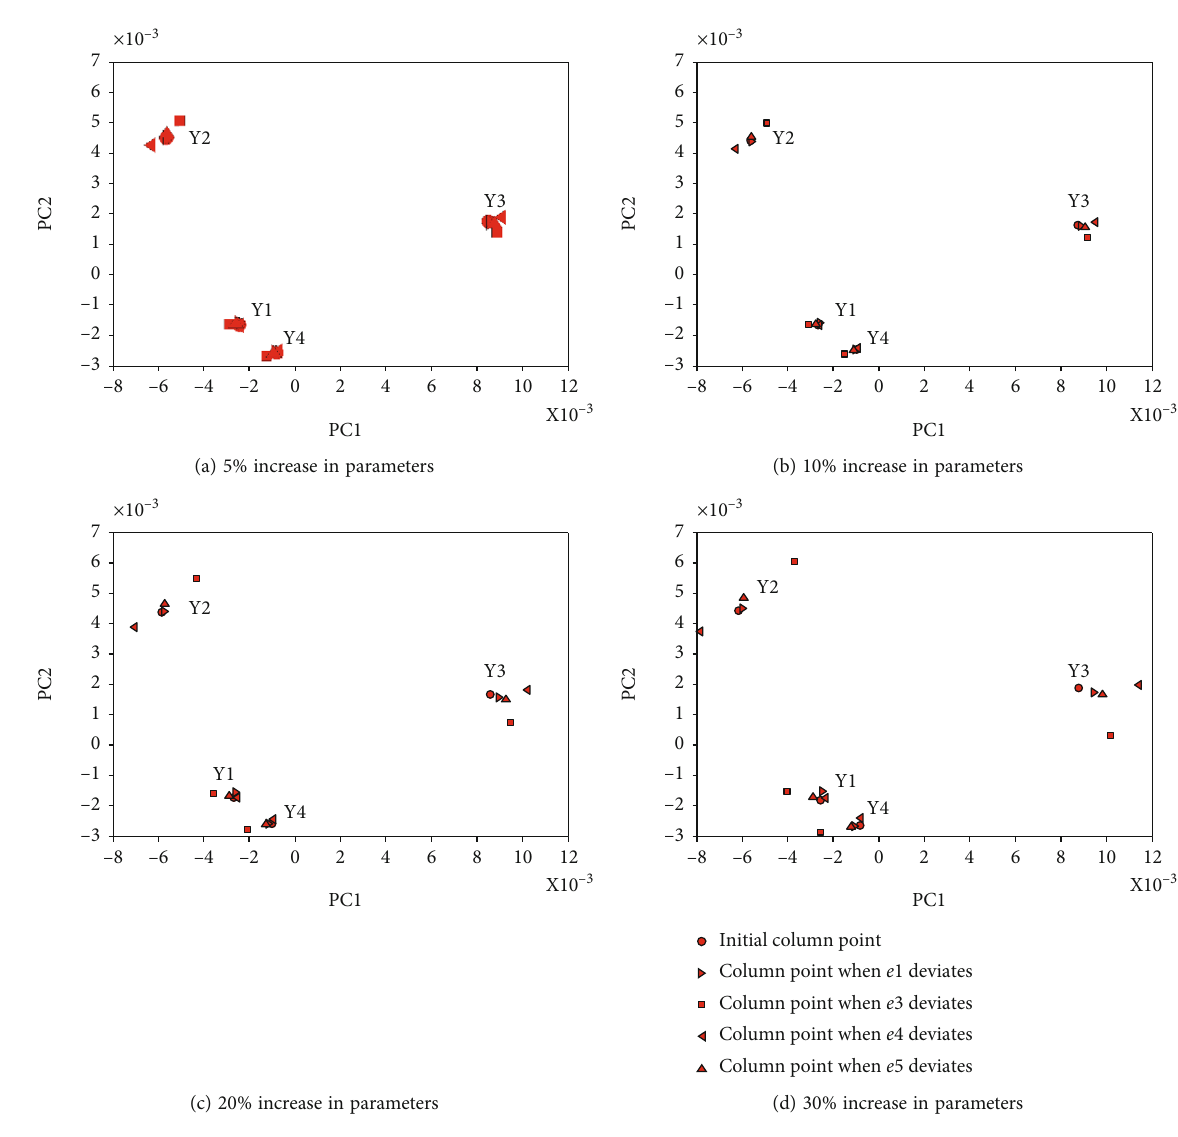
Figure 15: Relative position changes in the safety margin of the work boundary after the safety control strategy is